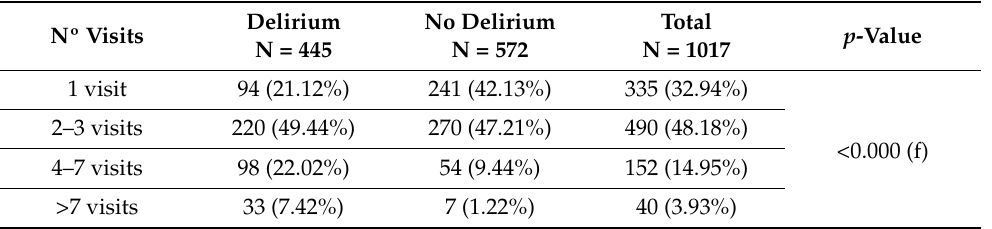
psychiatry (CLP) unit to patients with delirium versus other psychiatric